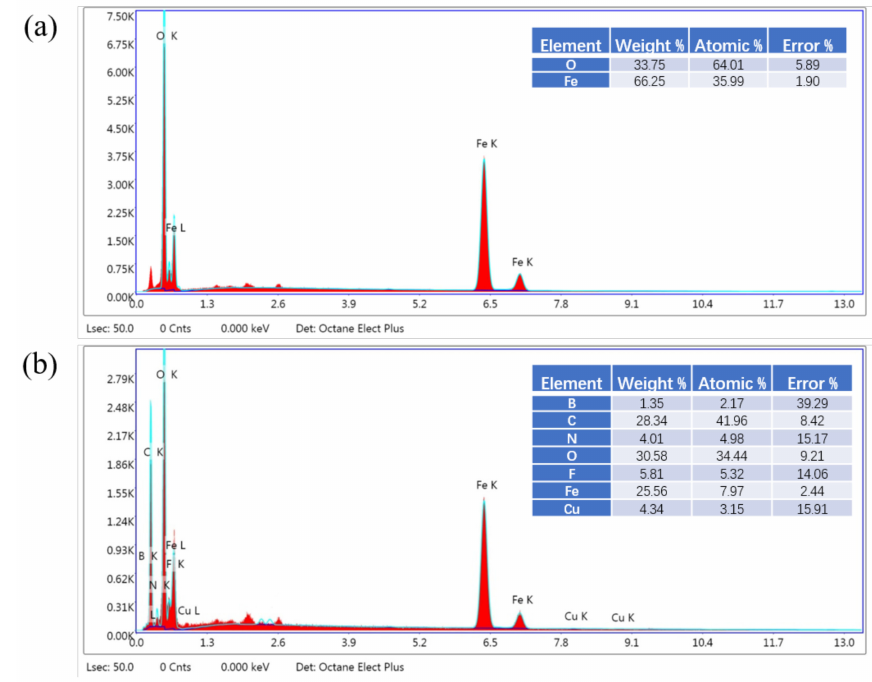
Figure 4. EDS characterization of Fe 3 O 4 ( a ) and MCIL–PEI–Cu ( b